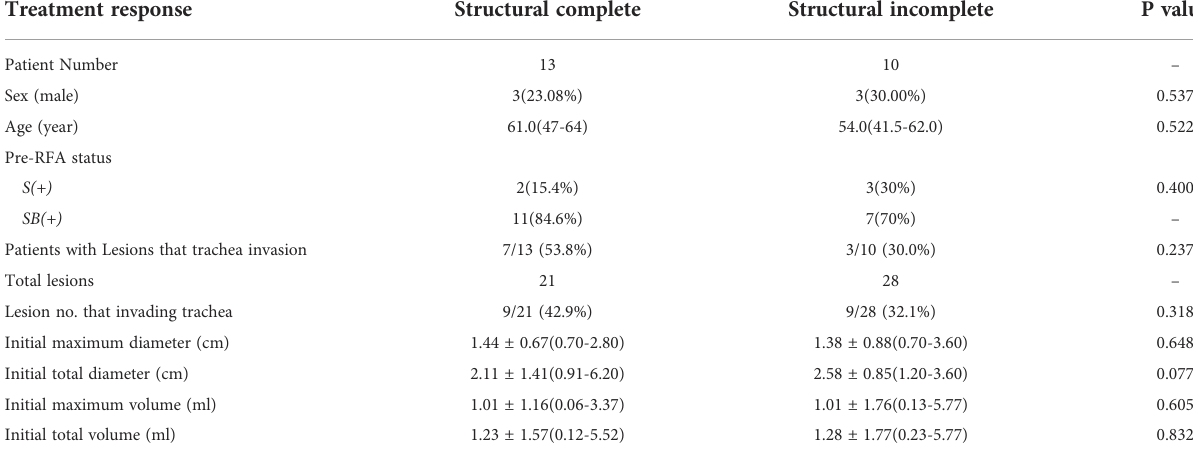
TABLE 2 Comparison of all patient with structural complete/incomplete response after RFA